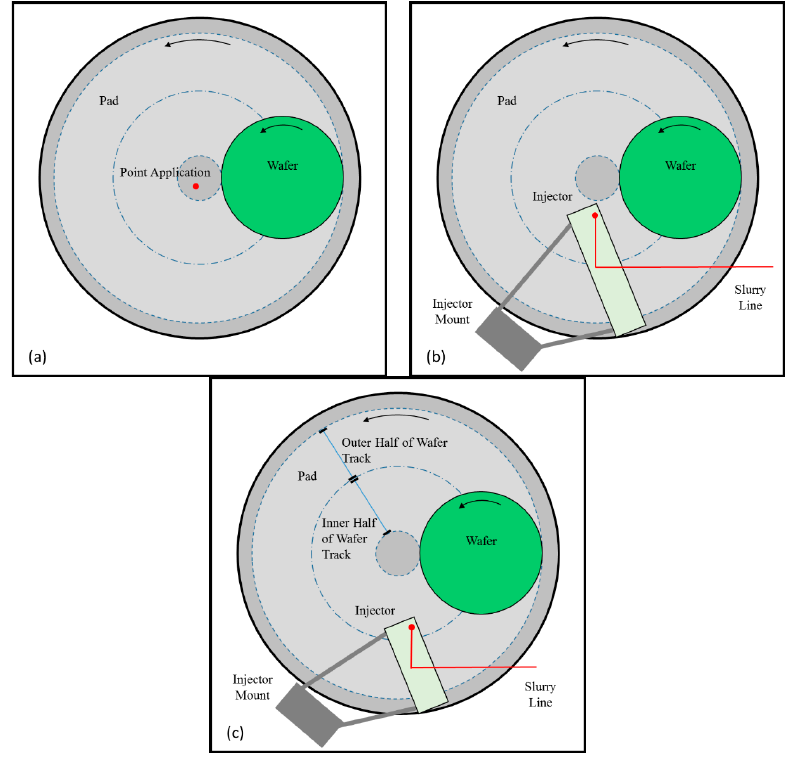
Figure 1. Top views of a polisher with ( a ) the standard slurry application method, ( b ) a slurry injection system (SIS) design that covers the whole wafer track, and ( c ) a SIS design that covers only the outside half of the wafer track.